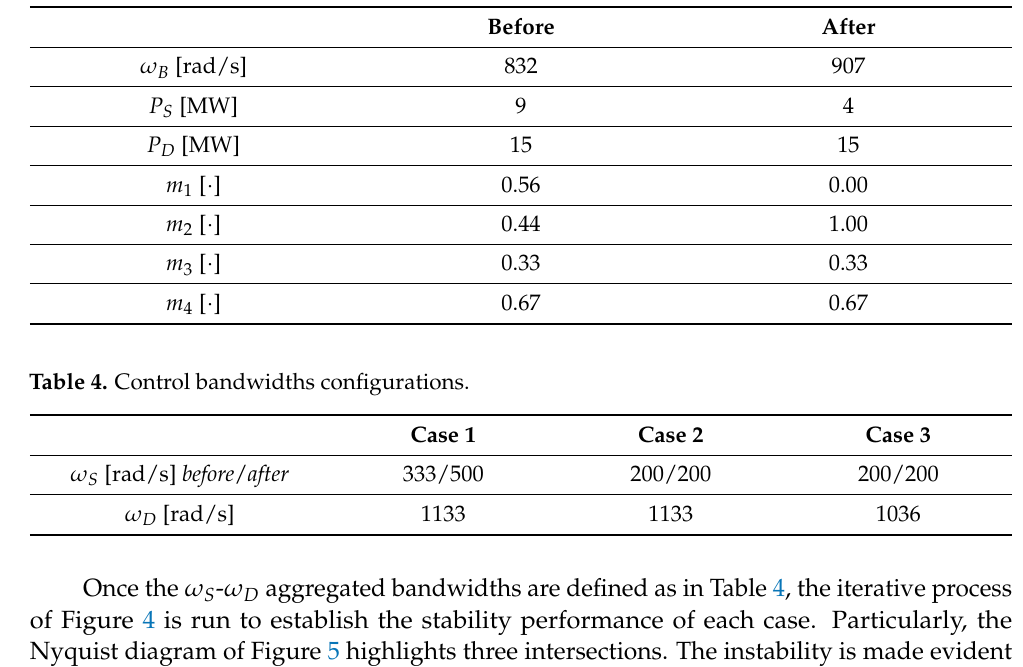
Table 3. Control bandwidths configurations.